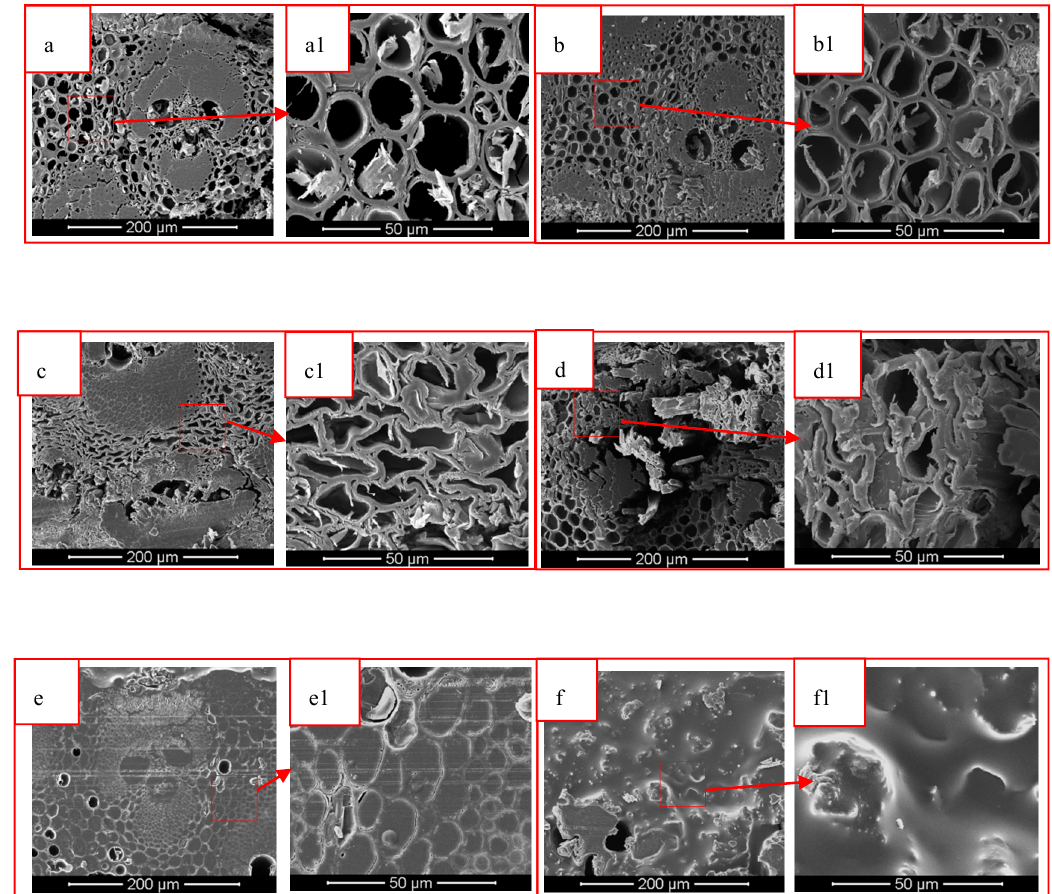
Figure 5. SEM images of OB and HOB before and after delignification and vacuum impregnation (( a ). OB ( b ). HOB ( c ) DOB ( d ) DHOB ( e ) TOB ( f ) THOB; ( a1–f1 ) were the enlarged images)).